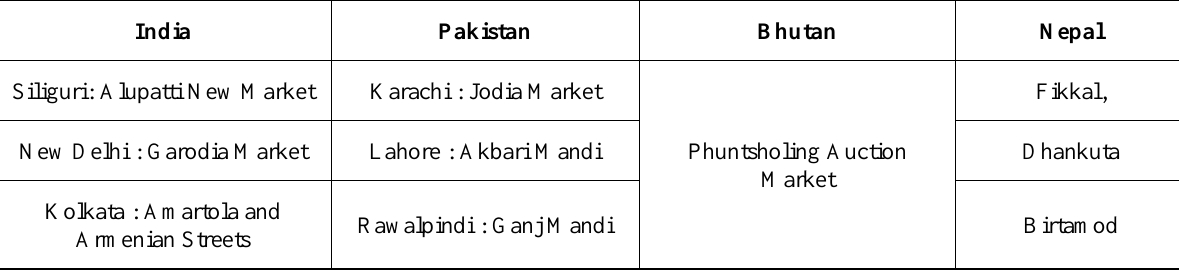
Table 11. Major market centers for